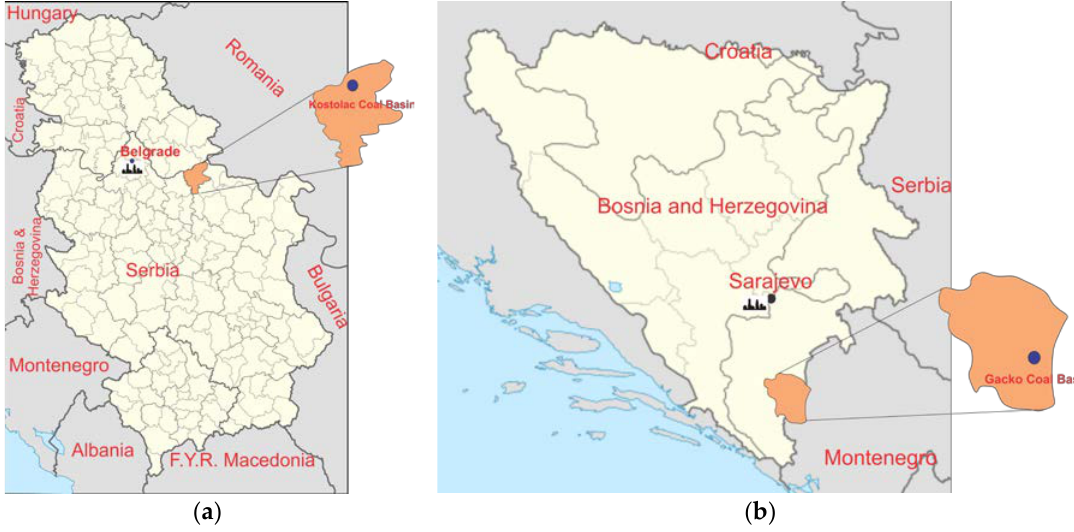
Figure 1. Map of Serbia with the location of the Kostolac coal basin ( a ); Map of Bosnia and Herzegovina with the location of the Gacko coal basin ( b ).